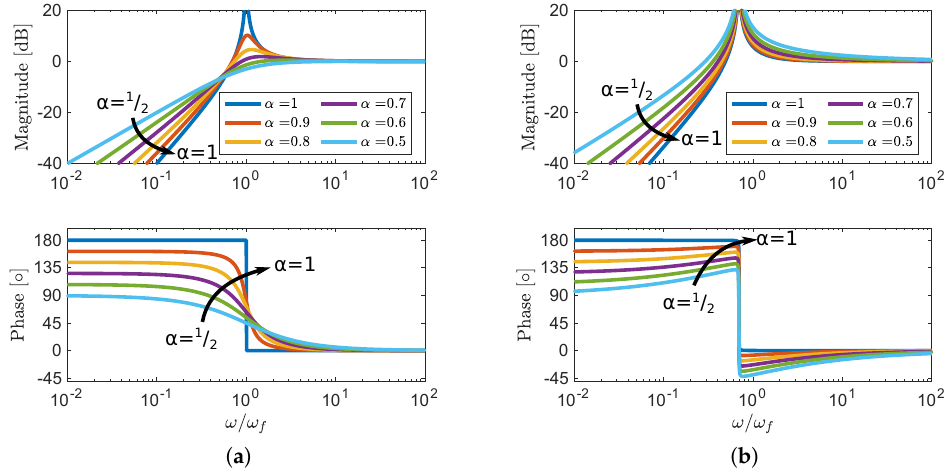
Figure 3. Frequency responses of a fractional-order attenuator with ζ f = 0 ( a ) and marginally stable fractional-order attenuators ( b ) for different values of α . All other parameters are